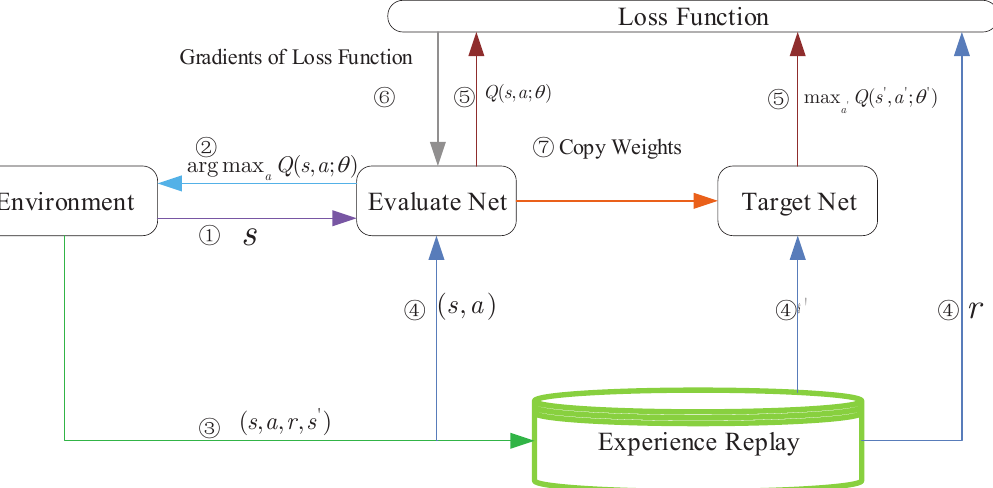
Figure 2. DQN algorithm frame